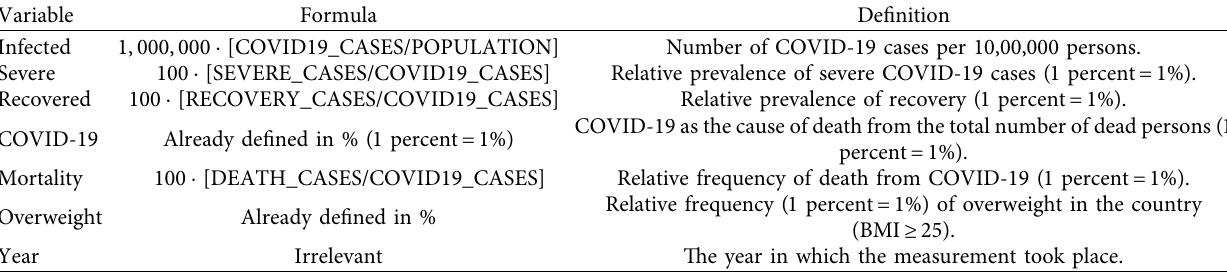
Table 1: Definition of indicators for COVID-19 and obesity.